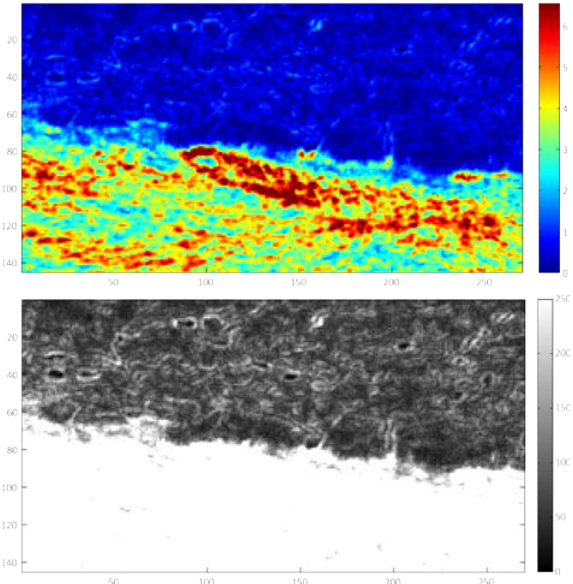
Figure 5-1: Magnitude of grey level differences before (top); 5-2: After pre-segmentation of spatio-temporal